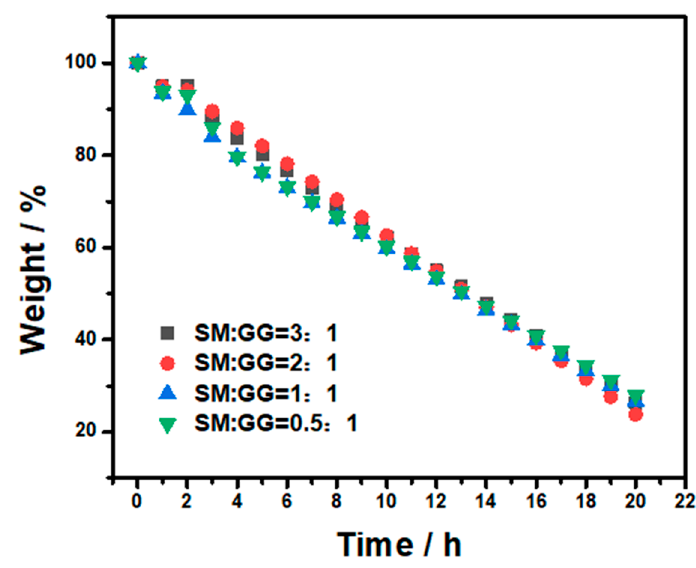
Figure 5. Fragrance release from the carrier systems with different ratios of SM and GG.